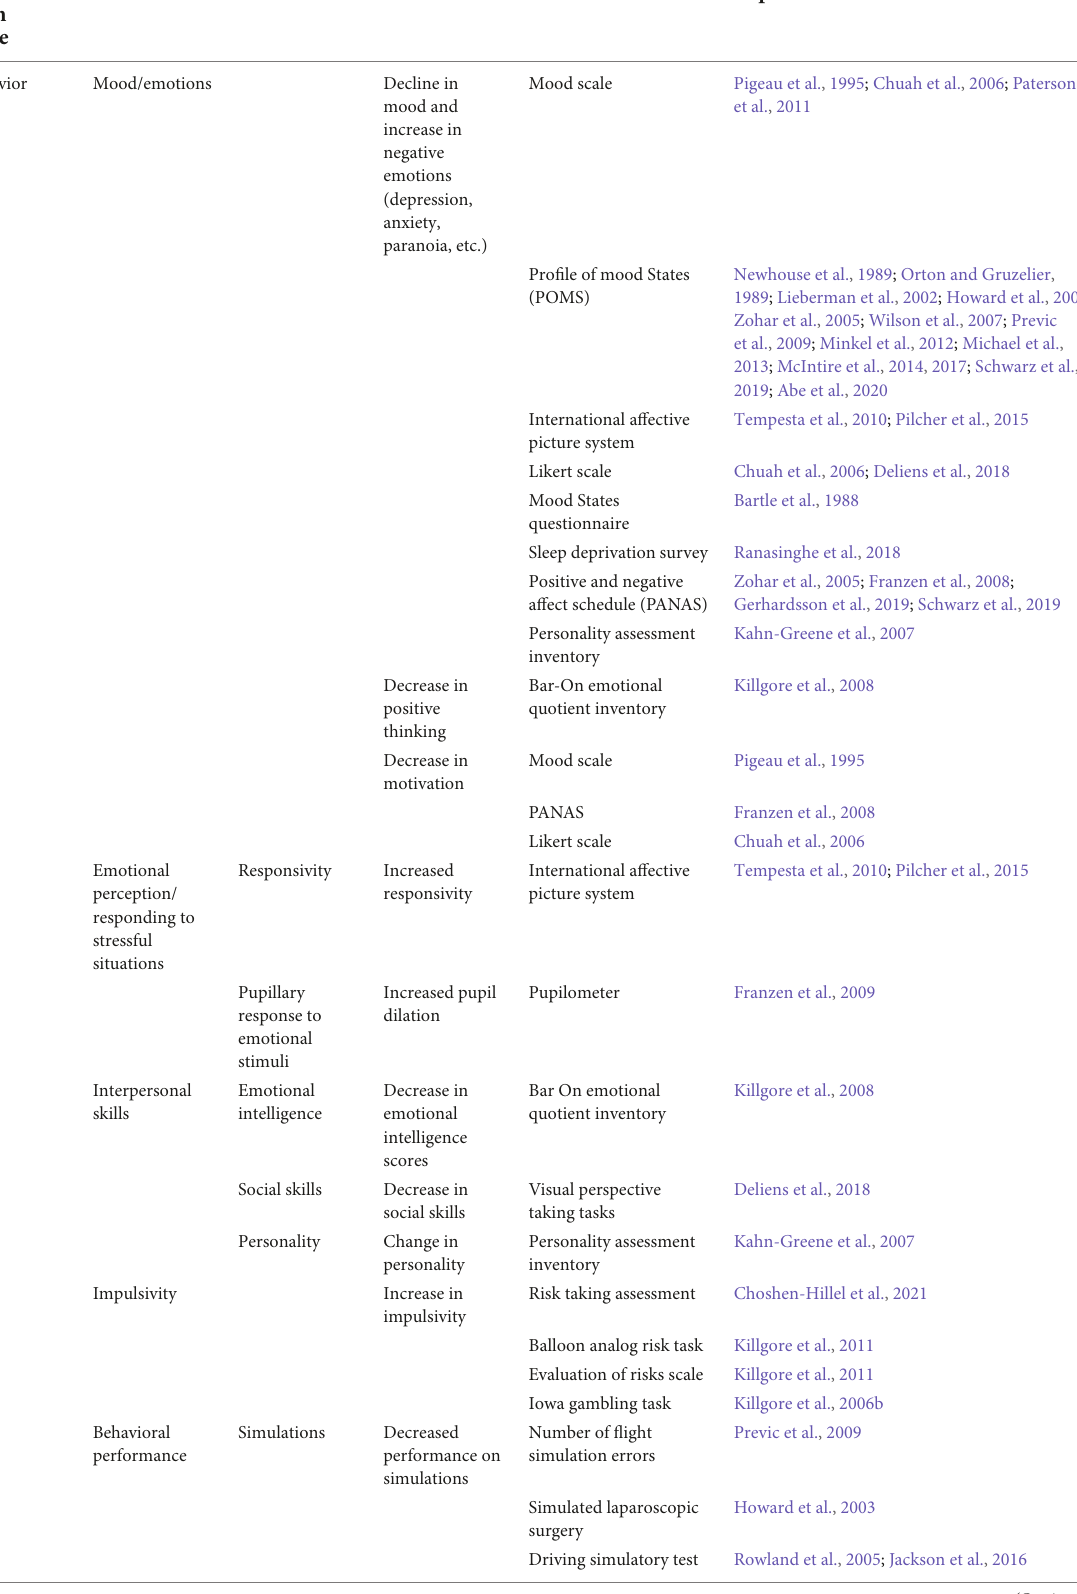
TABLE 1 Summary of the types of measurements for different types of effects of fatigue on behavior. Fatigue related variations